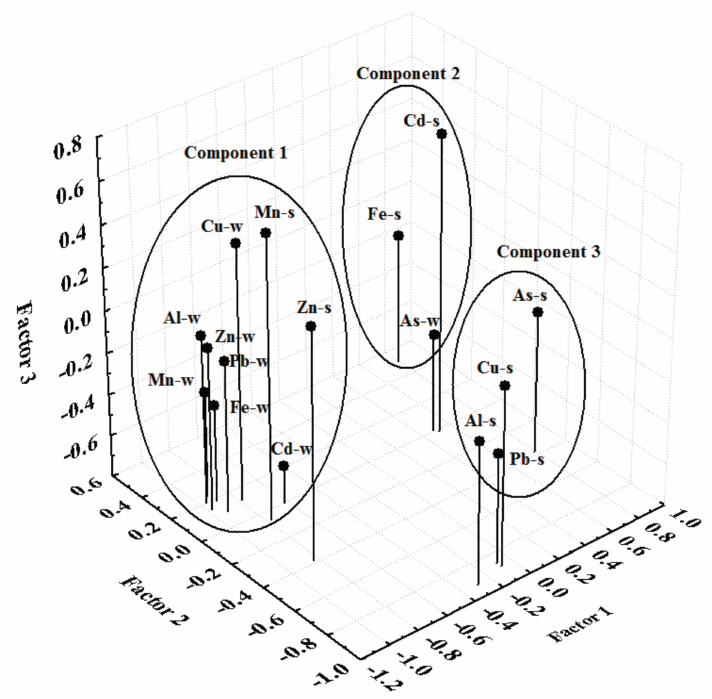
Figure 5. Graphical display of the principal components influencing the heavy metal concentration in sediment and water between sediment sites 1 and